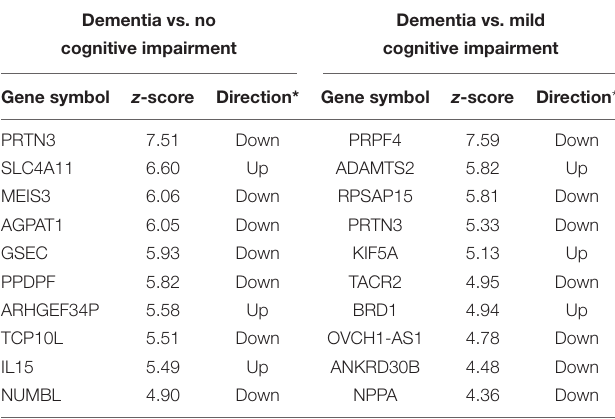
TABLE 1 | Top 10 genes for classifying the subjects into dementia and no cognitive impairment and for classifying subjects into mild cognitive impairment and